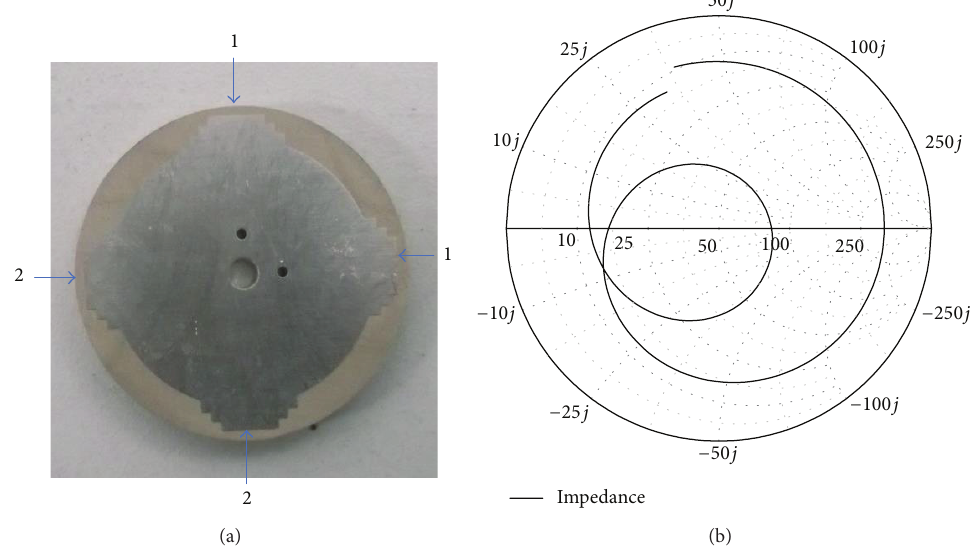
Figure 5: (a) The photo of improved antenna which contains two couples of stubs. (b) Measured number 2 component Smith chart versus frequency.